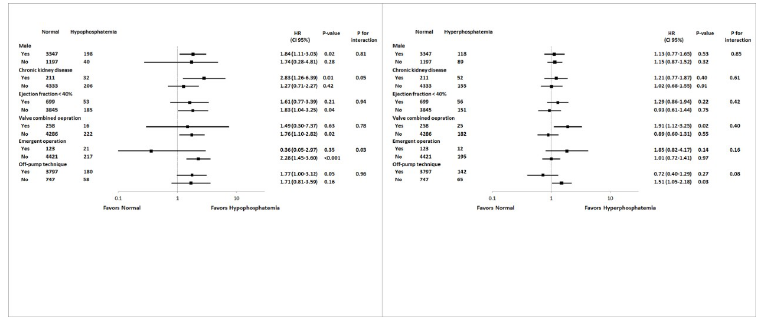
Fig 1. Subgroup analysis of all-cause death according to the following variables: male sex, chronic kidney disease, ejection fraction < 40%, valve combined operation, emergent operation, and the off-pump technique.